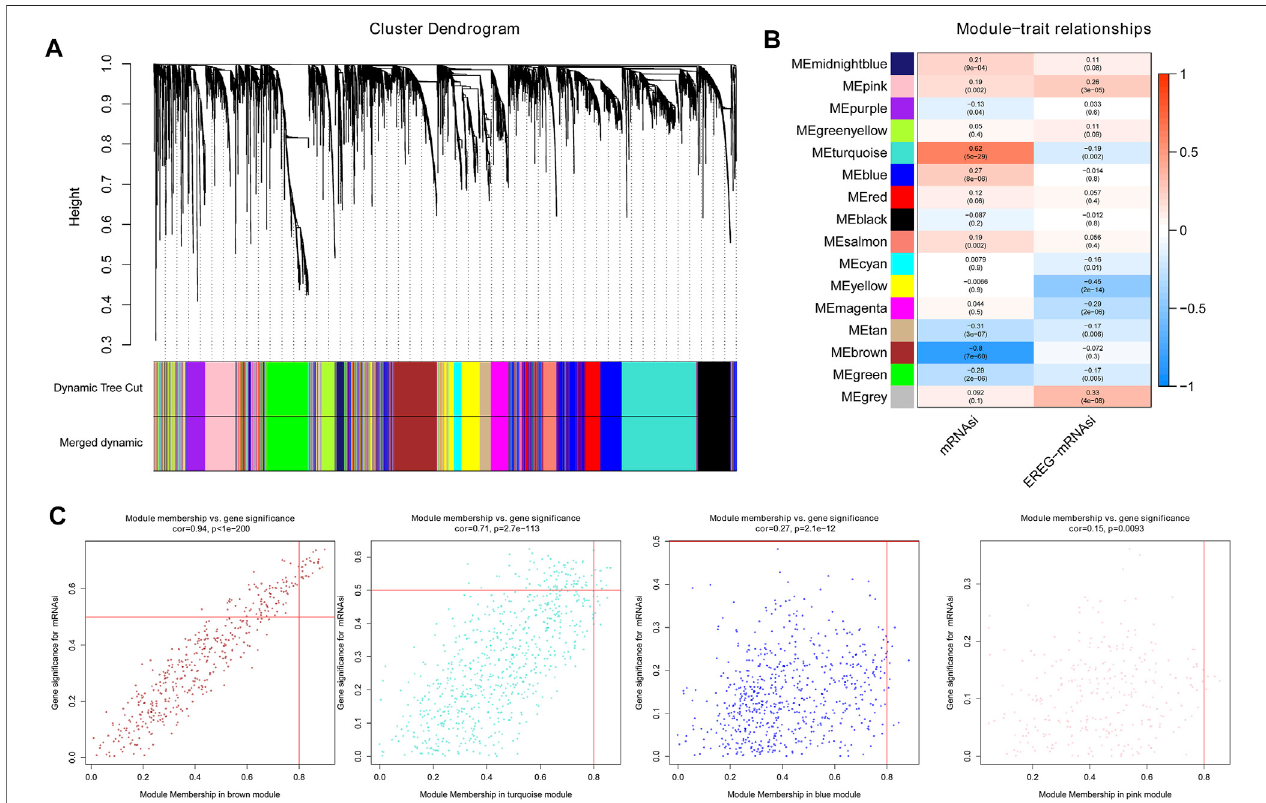
FIGURE 2 | The results of the WGCNA analysis. (A) . By cluster analysis, DEGs with a variance of up to 25% were placed in one module, and we obtained 16 modules for the following analysis; (B) . The turquoise module was most remarkably relevant to mRNAsi, with a correlation near to 0.7. Moreover, the brown module showed a relatively high negative correlation with mRNAsi, with a correlation to -0.8; (C) . Scatter plot of module eigengenes in the blue, brown, pink, and turquoise modules.